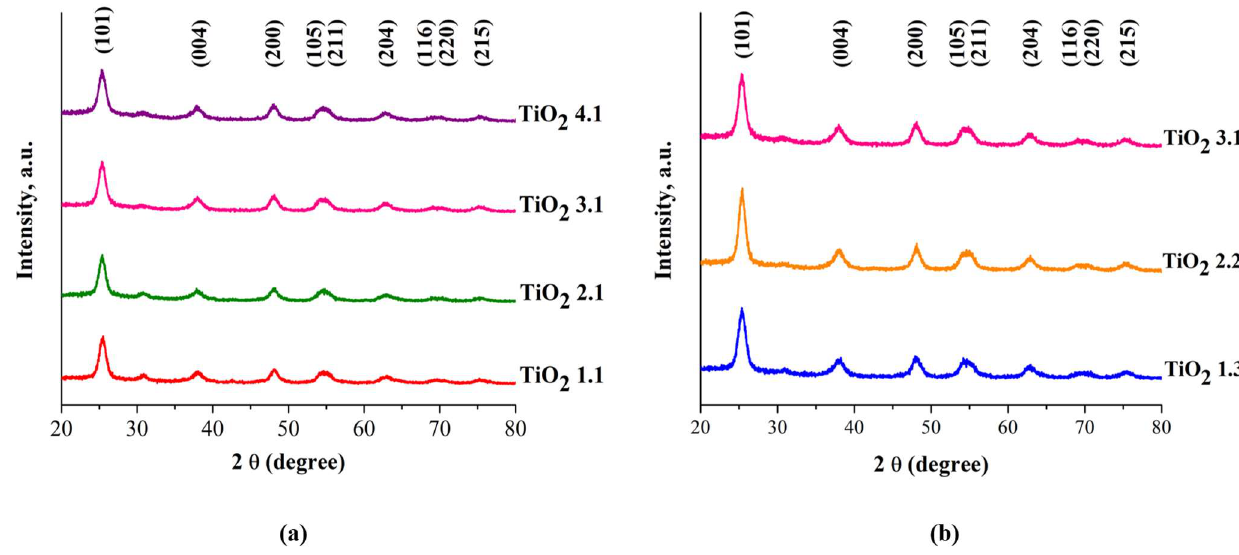
Figure 1. X-ray diffraction patterns for prepared TiO 2 samples by sol-gel techniques applying different ultrasound regimes: ( a ) by varying on cycle and keeping off cycle constant; ( b ) by varying both on/off cycles.